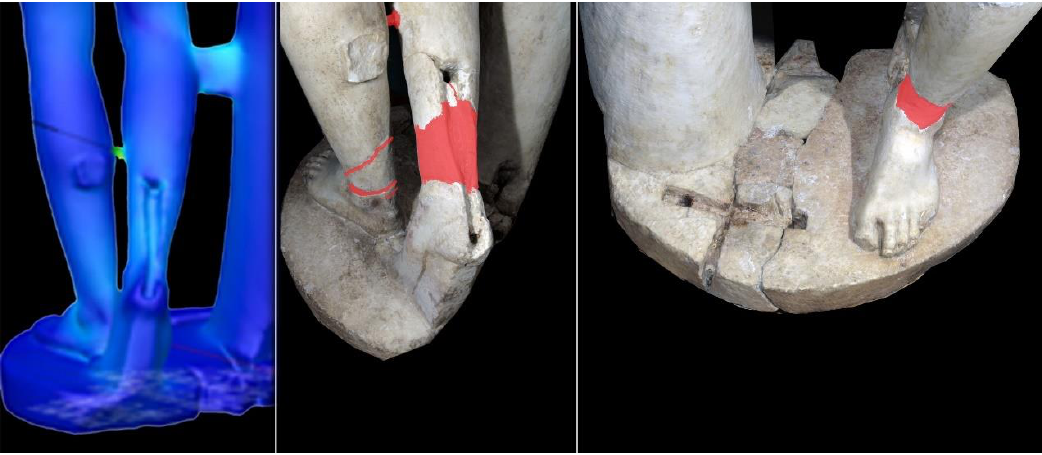
Figure 23. Results of static stress analysis versus previous restoration works.